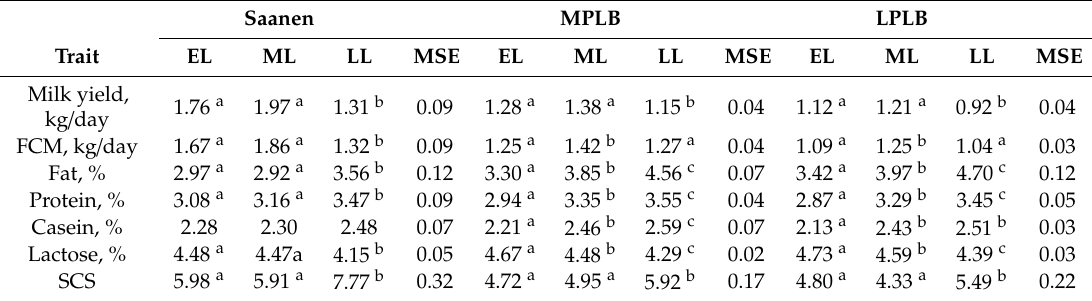
Table 5. E ff ect of the stage of lactation (early lactation, EL, 2–4 weeks in milking; medium lactation, ML, 5–10 weeks in milking; and late lactation, LL, 11–30 weeks) on the milk production traits of Saanen breed, Mediterranean medium production level breeds (MPLB: Maltese and Jonica breeds), and low production level breeds (LPLB: Rossa Mediterranea, Girgentana, and Garganica breeds). Saanen MPLB